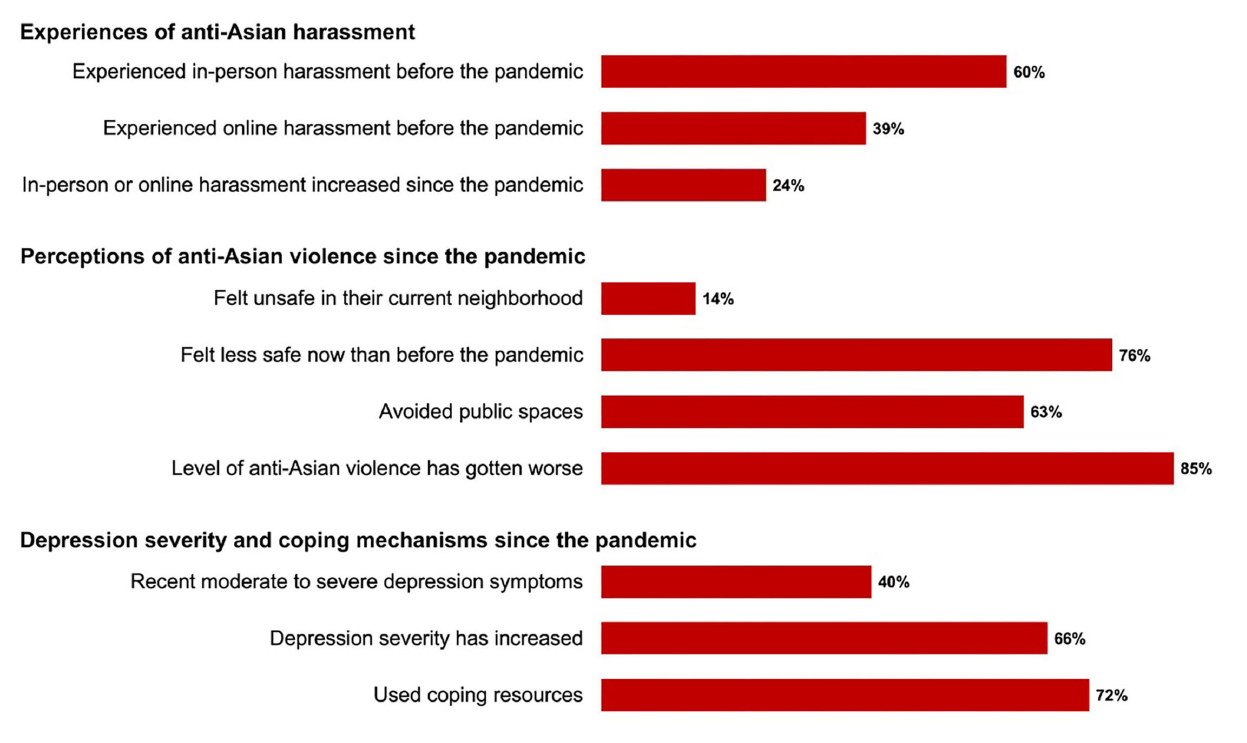
FIGURE1 Distribution of perceptions and experiences of anti-Asian violence and depression severity since the pandemic among YAAHS respondents ( N = 176).